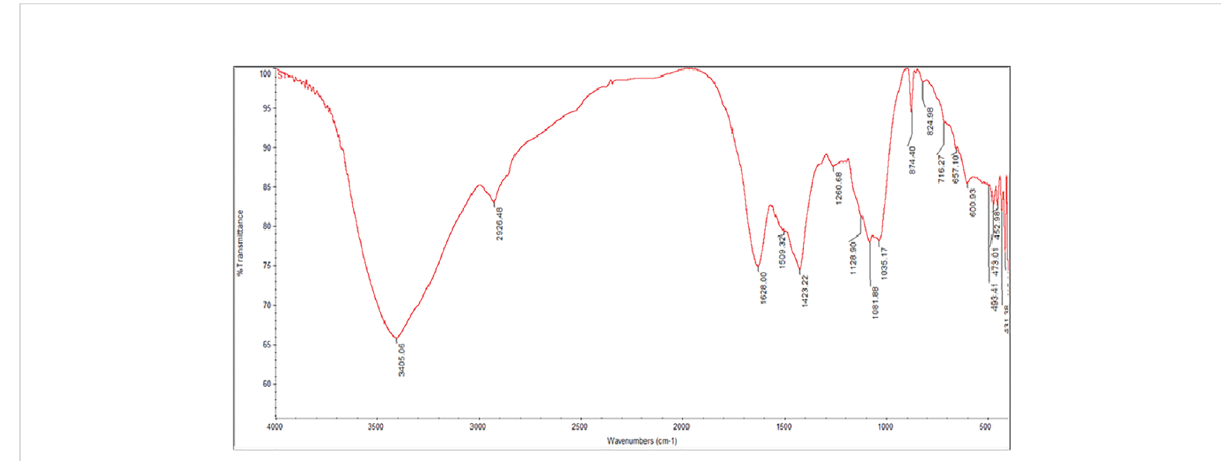
FIGURE 1 FTIR spectra of Polycladia myrica aqueous